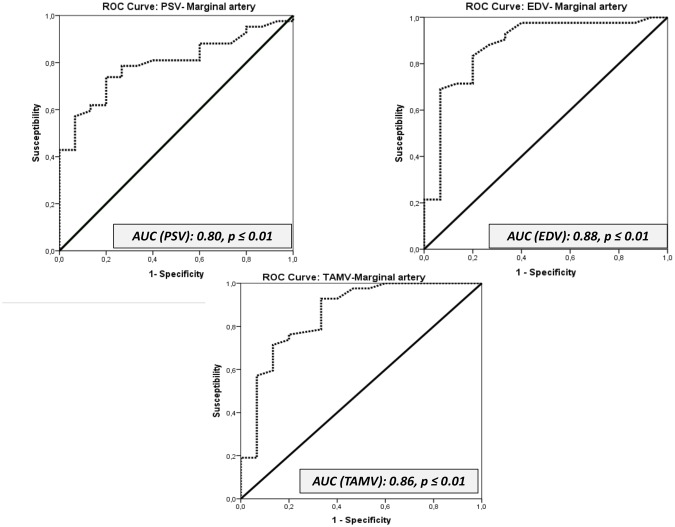
Receiver operating characteristic (ROC) curves for the parameters PSV, EDV, TAMV.AUC: Area under the Curve.